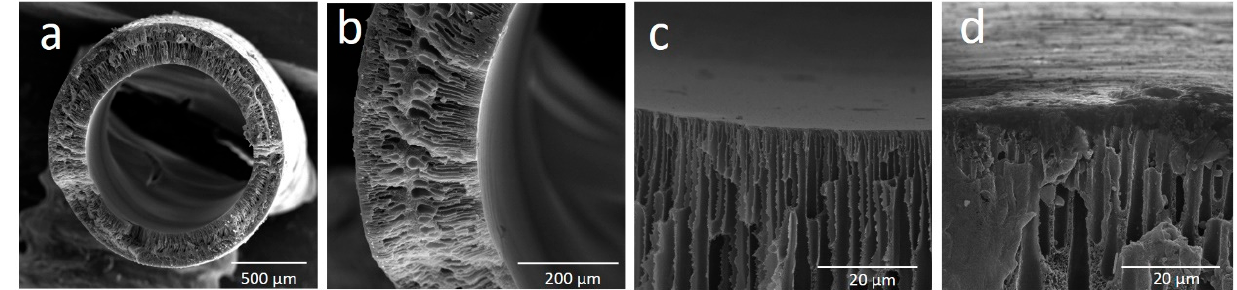
Figure 1. SEM pictures of uncoated PEI hollow fibers: ( a ) overall cross-section, ( b ) enlarged cross-section, ( c ) inner side, and ( d ) outer side.